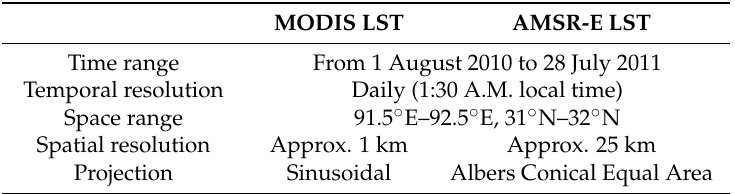
Table 1. Specifications of the satellite-derived LST products used in this